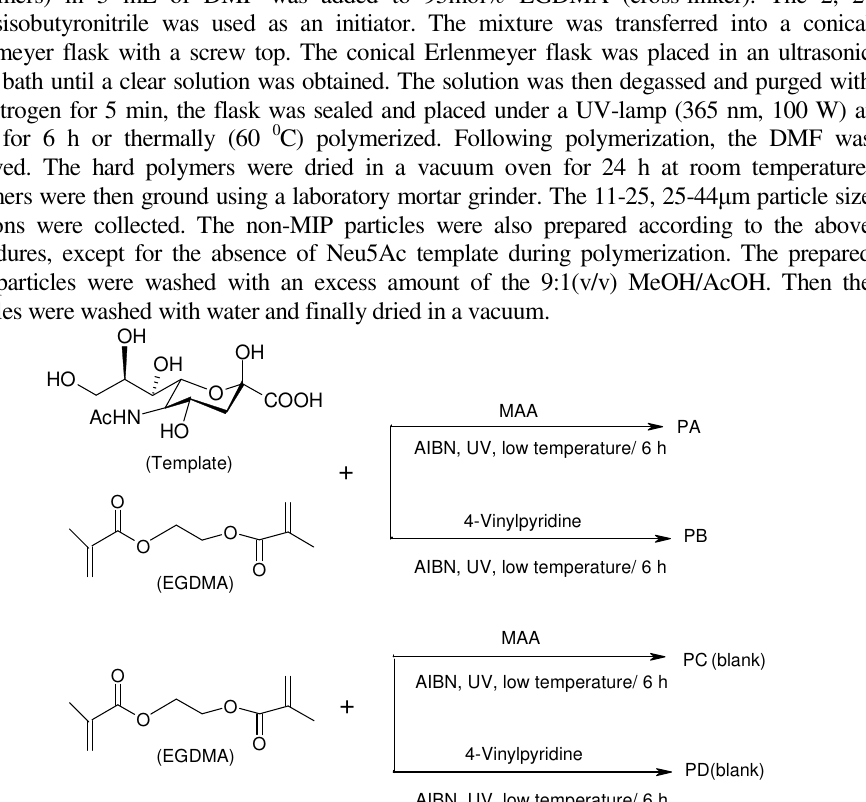
Figure 2 . Schematic representation of the synthesis of MIPs for Nsu5AC as template and MAA, 4-VP as functional